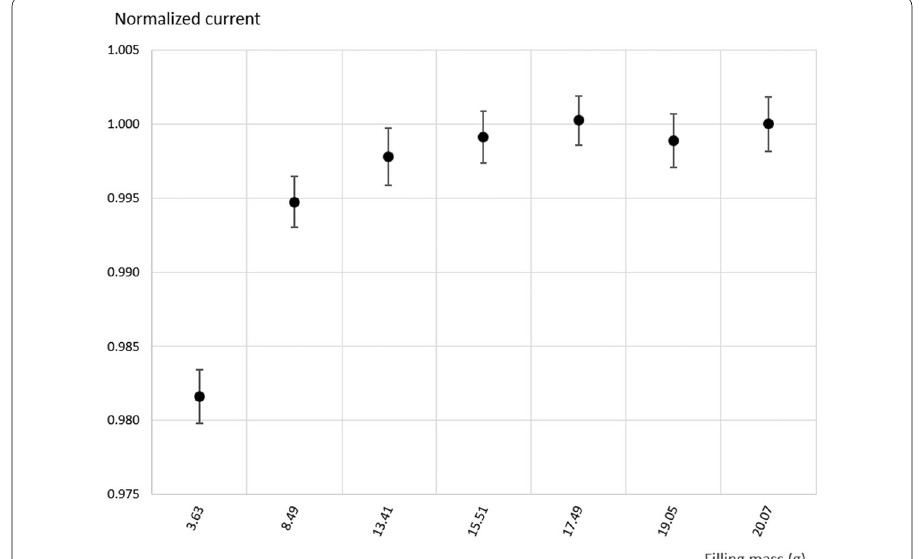
Fig. 13 Normalized current values for different filling levels using a GMP